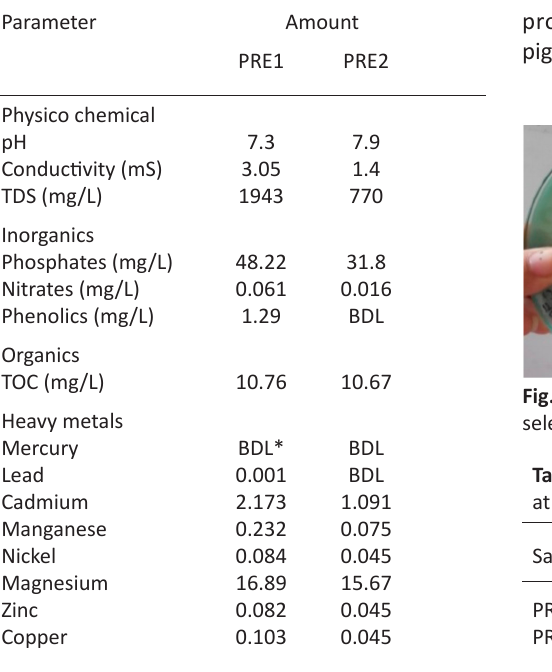
Table 1. Profile of PRE from refinery industry at